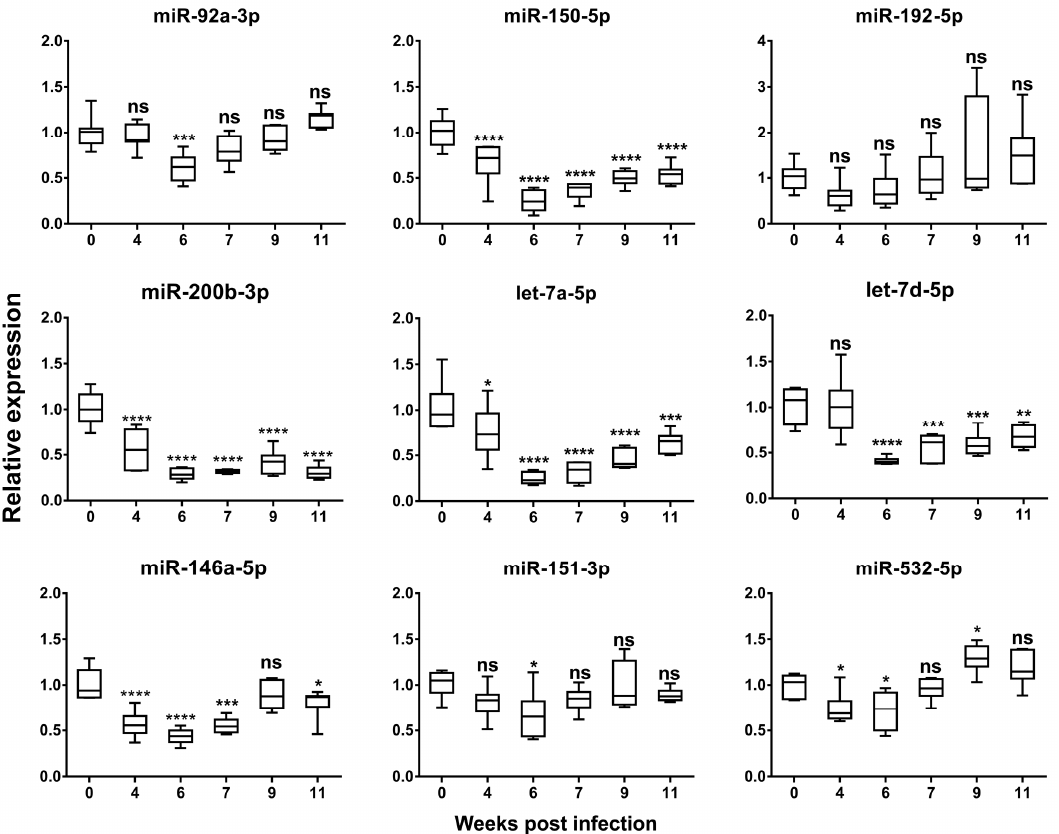
Figure 2. Temporal expression of serum exomiRs in C57BL/6 mice during S. japonicum infection. (Week 0, n = 7; week 4, n = 7; week 6, n = 6; week 7, n = 6; week 9, n = 7; week 11, n = 7). Boxes represent the interquartile range of the data. The hash marks above and below the boxes indicate the 90th and 10th percentiles for each group, respectively, while the lines across the boxes indicate the median values. P values were calculated using One-way ANOVA. (ns = no significant difference, * = p < 0.05, ** = p < 0.01, *** = p < 0.001, **** = p < 0.0001). Table 3. Correlations of the levels of exosomal miRNAs (exomiRs) in serum with liver pathological parameters in C57BL / 6 mice during S. japonicum infection.